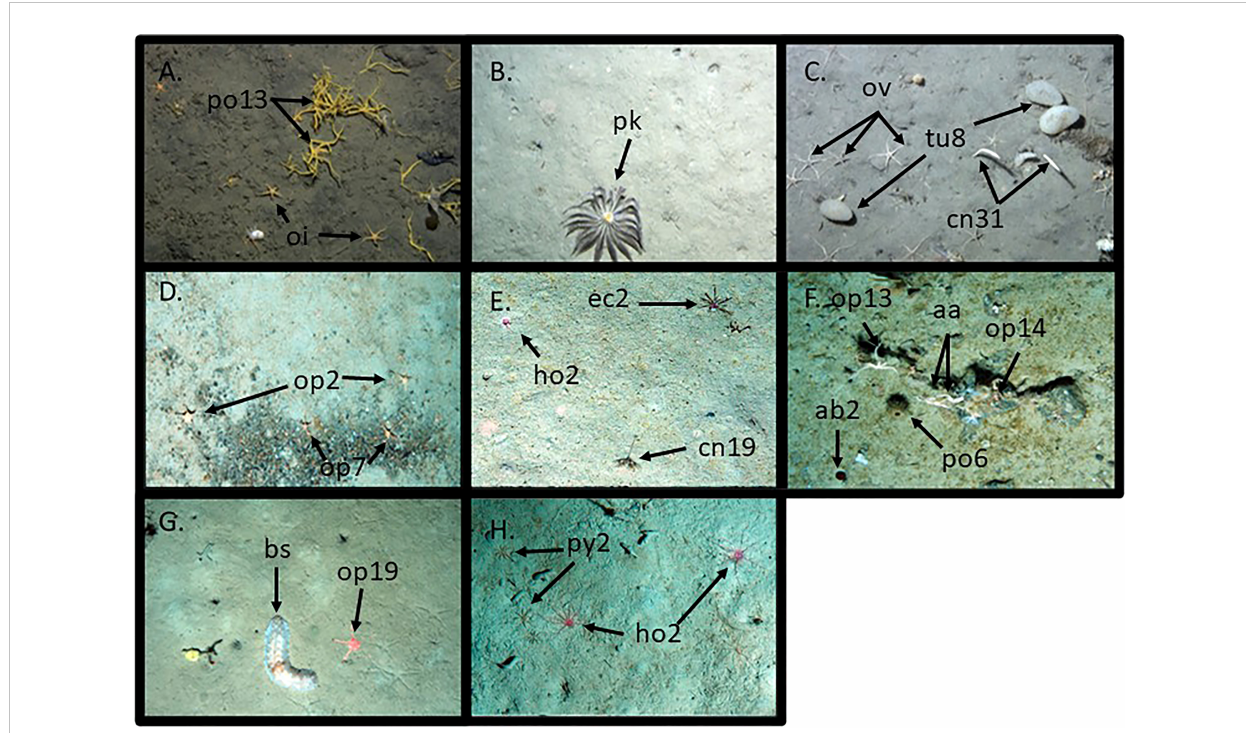
FIGURE 1 Examples of organismal diversity from each of the sites: (A) Montravel Rock, (B) Recovitza Island, (C) Seymour Island, (D) Bellingshausen, (E) Wright ’ s Gulf, (F) Eastern Amundsen, (G) Near Ross Sea, (H) Mid Ross Sea. Macrofaunal identi fi cations are: aa = Astrotoma agassizii , ab2 = Abatus sp. 2, bs = Bathyplotes sp. 1, cn19 = cnidarian 19, likely Umbellula sp., cn31 = cnidarian 31, likely Primnoella sp., echinoid 2 = echinoid 2, ho2 = holothurian 2, oi = Ophioplinthus spp. and Iophon sp. symbiosis, op2 =ophiuroid 2, op13 = ophiuroid 13, op14 = ophiuroid 14, ov = Ophionotus victoriae , pk = Promachocrinus kerguluensis , po6 = porifera 6, po13 = porifera 13, py2 = pychnogonid 2, and tu8 = tunicate